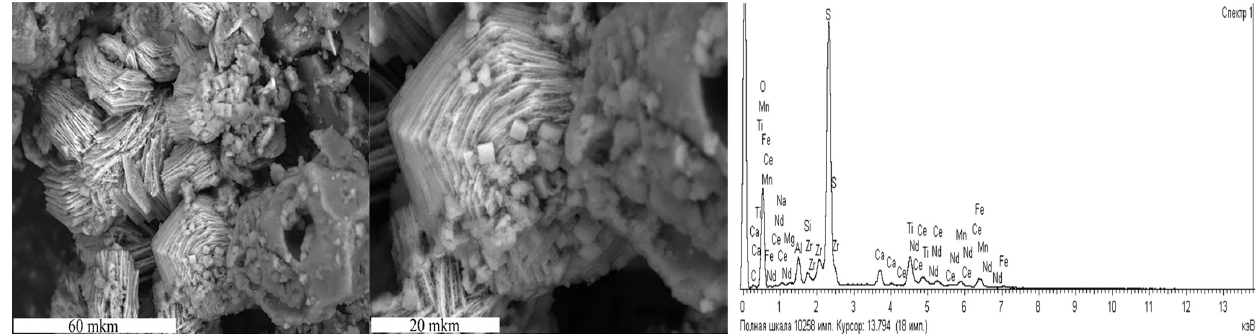
Figure 4. Secondary crystalline phases captured into gel-like silicate after leaching with H 2 SO 4 solution: intergrowths and single crystals of sulfate of rare earth element REE 2 (SO 4 ) 3 .